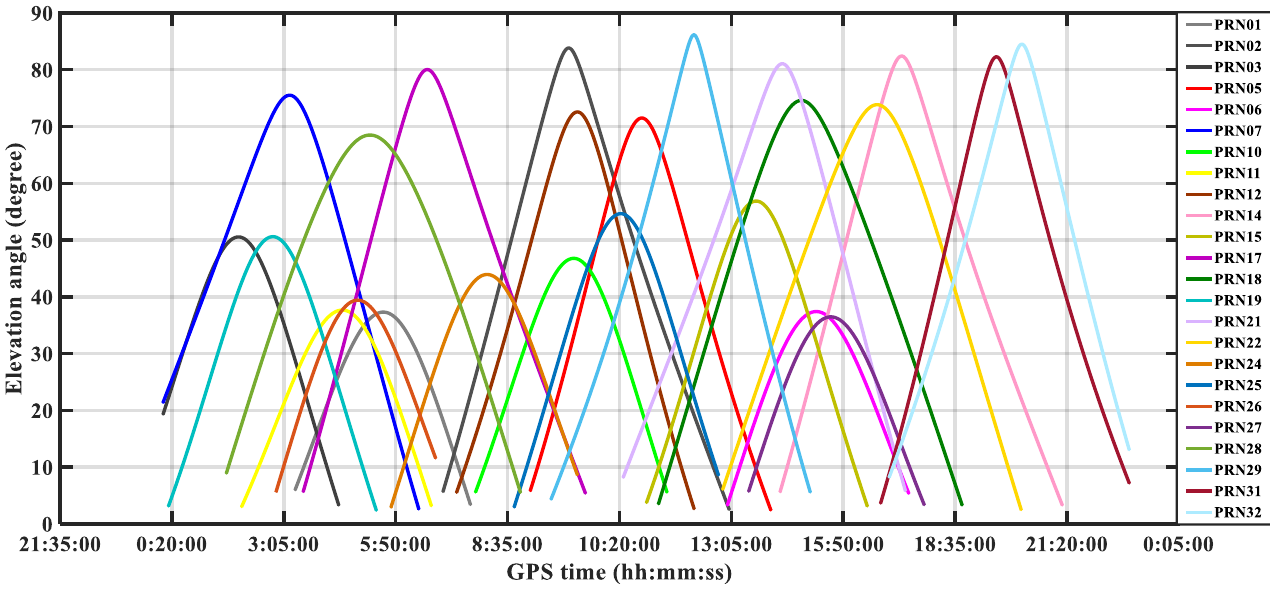
Figure 6. Changes in the elevation angles of almost all GPS satellites at P041.